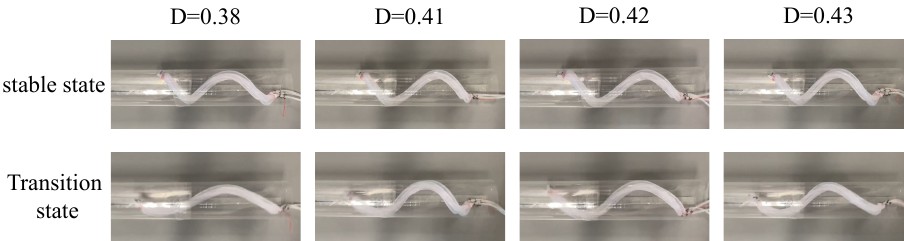
Figure 9. Pneumatic control.